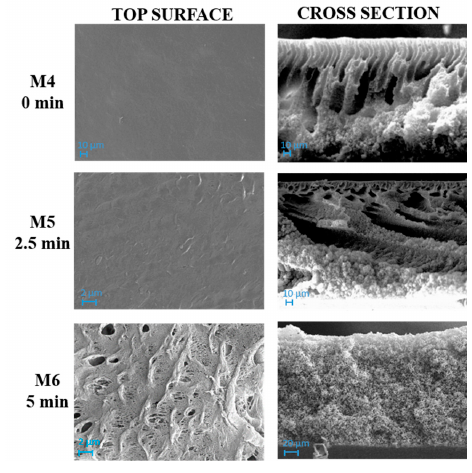
Figure 4. SEM images of M4, M5 and M6 membranes prepared with PVDF, PVP, PEG and TEP and exposed to humidity for 0, 2.5 and 5 min, respectively. Magnification: top surface 10,000 × , cross section 1000 ×